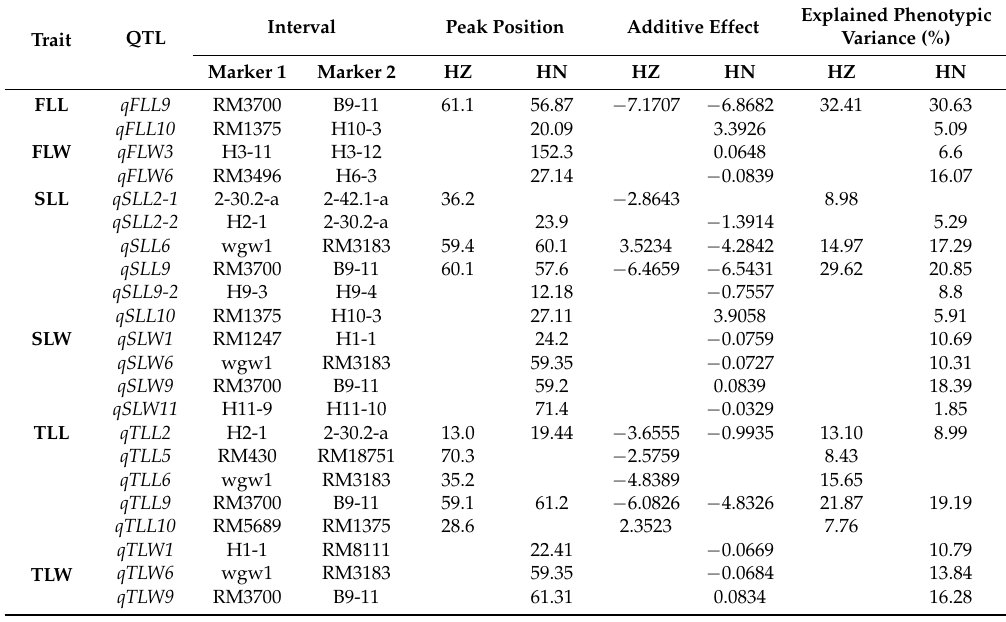
Table 2. Locations of quantitative trait loci (QTLs) for leaf traits in the RIL population.